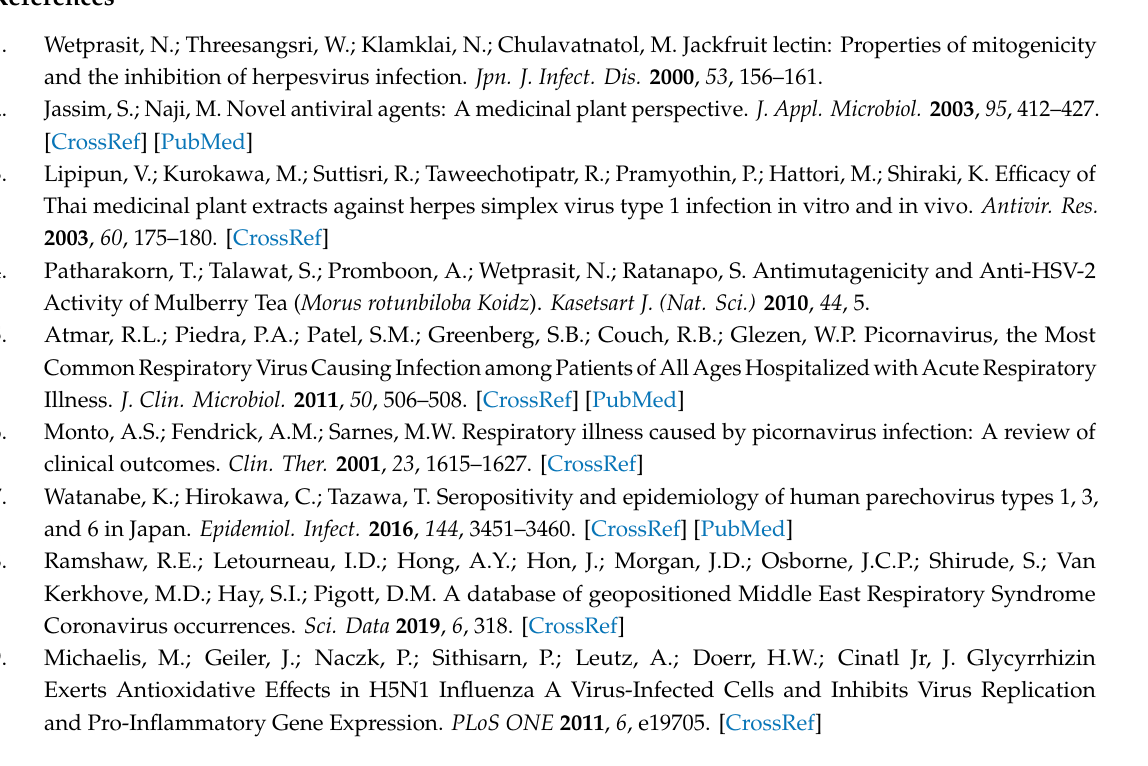
Supplementary Materials: The following are available online. Figure S1: Normalized antiviral e ff ects of kuwanon G on L-132 cells infected with HCoV 229E (2 independent experiments; 8